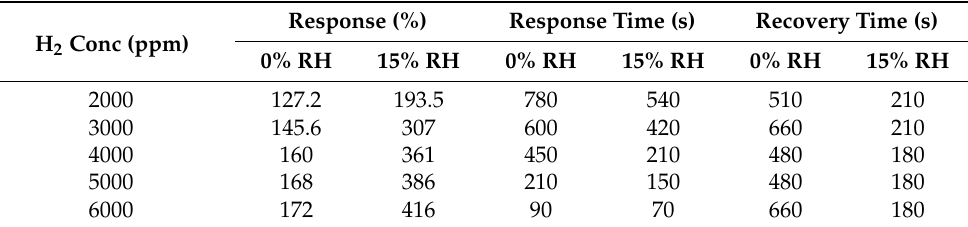
Table 4. Sensing parameters towards H 2 different concentrations at 100 ◦ C, 0% RH, and 15% RH under UV (365 nm)